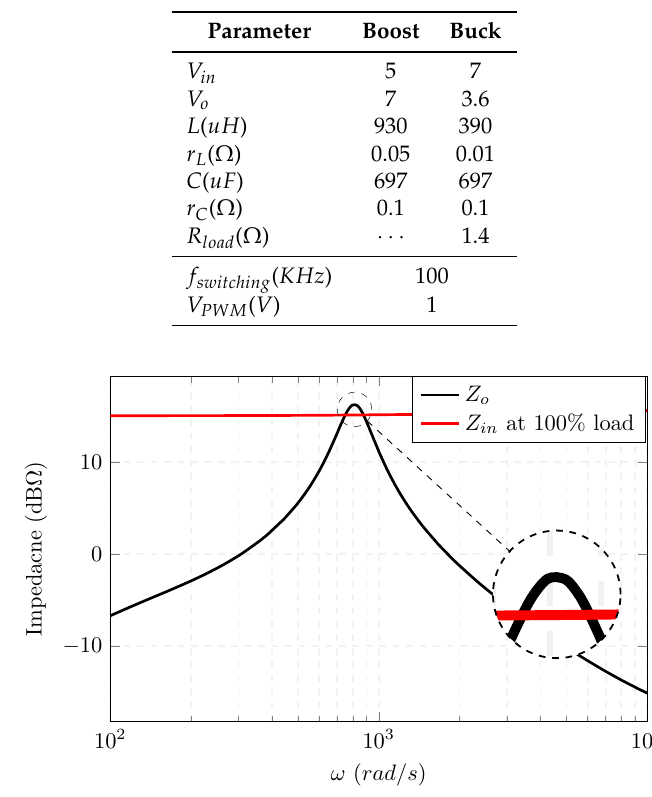
Figure 18. Cascaded system with a boost converter as the LRC. Table 2. Numerical parameters of the test system in Figure 18.